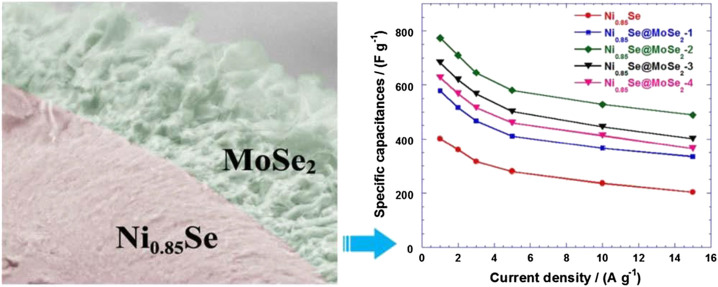
Ni0.85Se@MoSe2 nanosheet arrays as the electrode for high-performance supercapacitors.